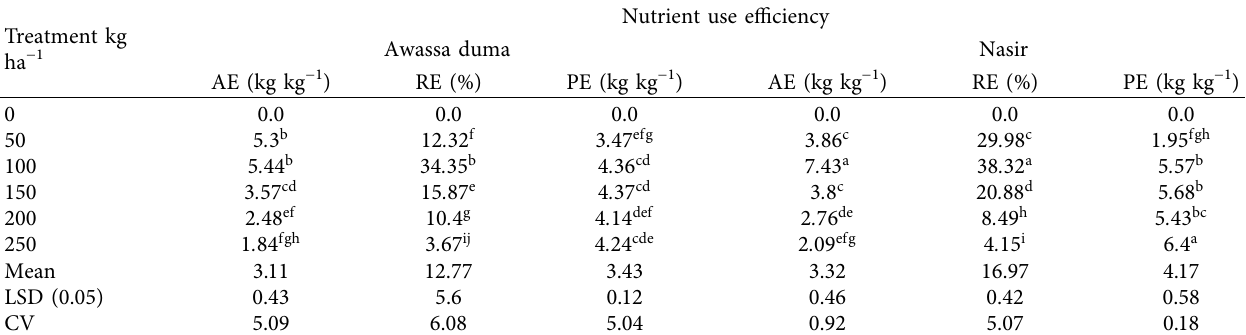
Table 6: Efect of blended fertilizer rates on nutrient use efciency of common bean varieties. Treatment kg